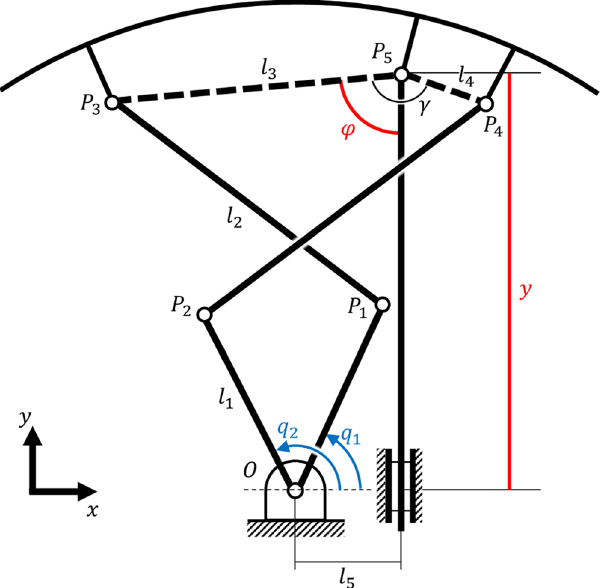
Figure 3. Kinematic diagram of the 2-DOF 7-bar linkage. Two inputs q 1 and q 2 yield two DOFs in ϕ and y